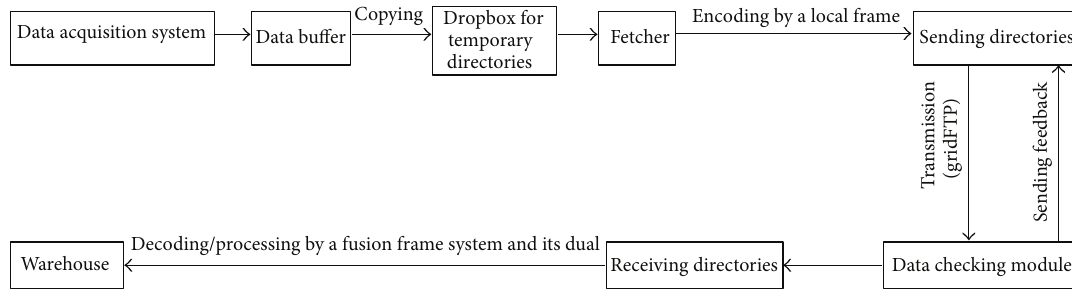
Figure 1: The experimental data transmission course of high energy